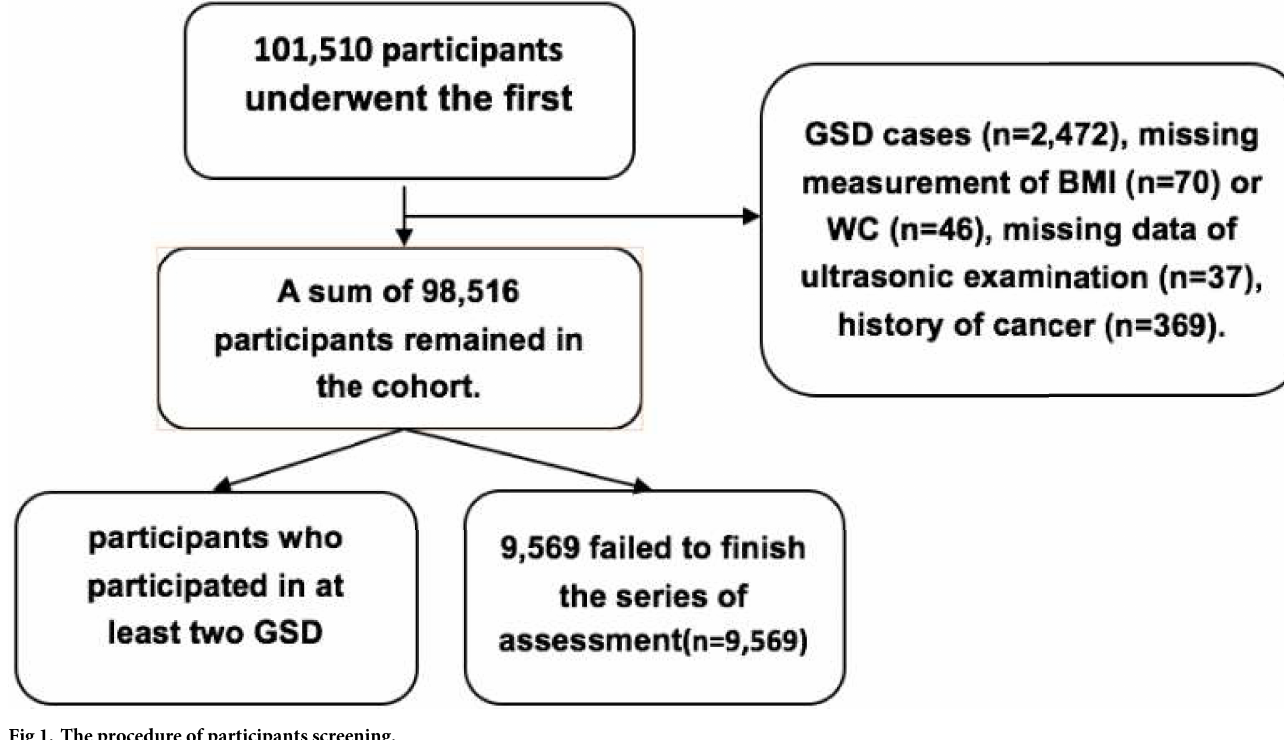
Fig 1. The procedure of participants